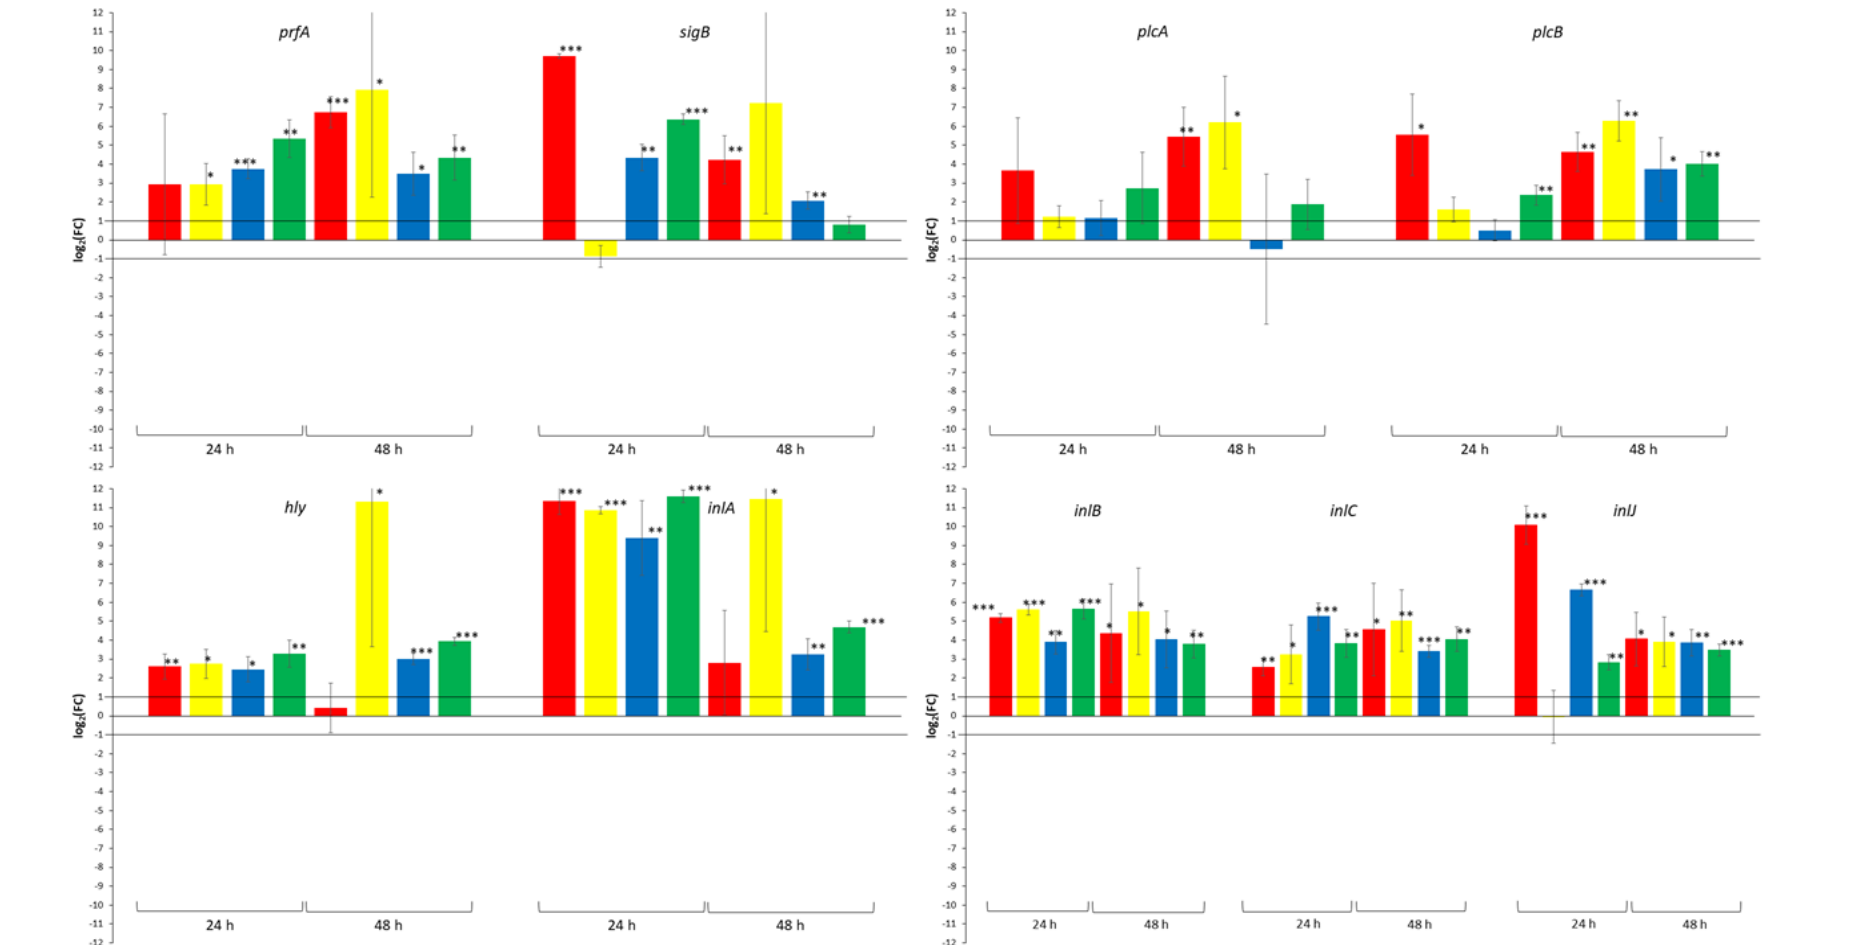
Figure 3. Effect of incubation temperature on the relative transcription of prfA , sigB , hly , plcA , plcB , inlA , inlB , inlC and inlJ , during growth of L. monocytogenes strain LQC 15257 in monoculture (red bars) and in coculture with S. cerevisiae strains Y32 (yellow bars), Y34 (blue bars) and Y37 (green bars). Growth of the pathogen in mono-or co-culture at 5 °C was used as control. Error bars represent the standard deviation of the mean value. Presence of asterisks indicates that the relative transcription was above 1 or below − 1 (the values that were used as threshold) at p value indicated by the number of asterisks (* p < 0.05; ** p < 0.01; *** p < 0.001).